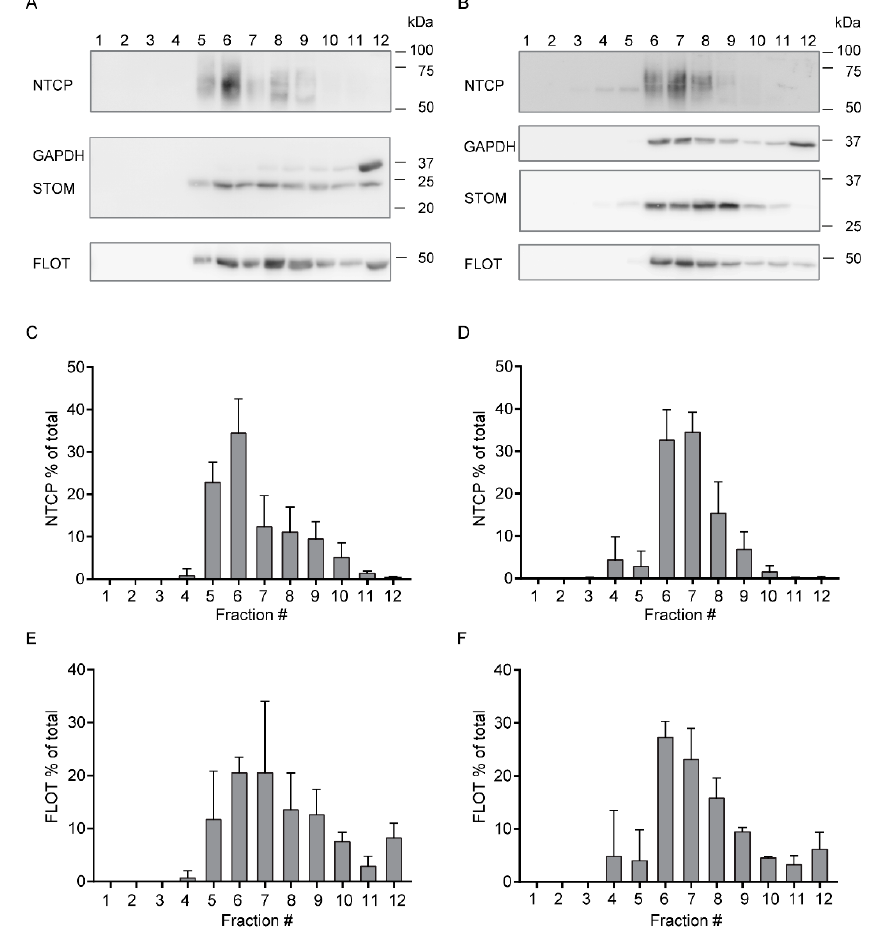
Figure 5. Effect of stomatin overexpression on NTCP repartition in lipid rafts. ( A , B ) Detection of proteins in fractions (number indicated at the top) obtained after Lubrol treatment and sucrose gradient separation in HepG2 cells expressing HA-hNTCP and either overexpressing an empty vector (EV, A) or V5-stomatin (V5-STOM, B). Western blots are representative of three independent experiments. ( C – F ) Distribution of NTCP ( C , D ) and flotillin (FLOT,E,F) per fractions in HepG2 cells expressing HA-hNTCP and either an empty vector (EV, C, E) or V5-STOM ( D , F ).n = 3, Graphs show mean +/ −